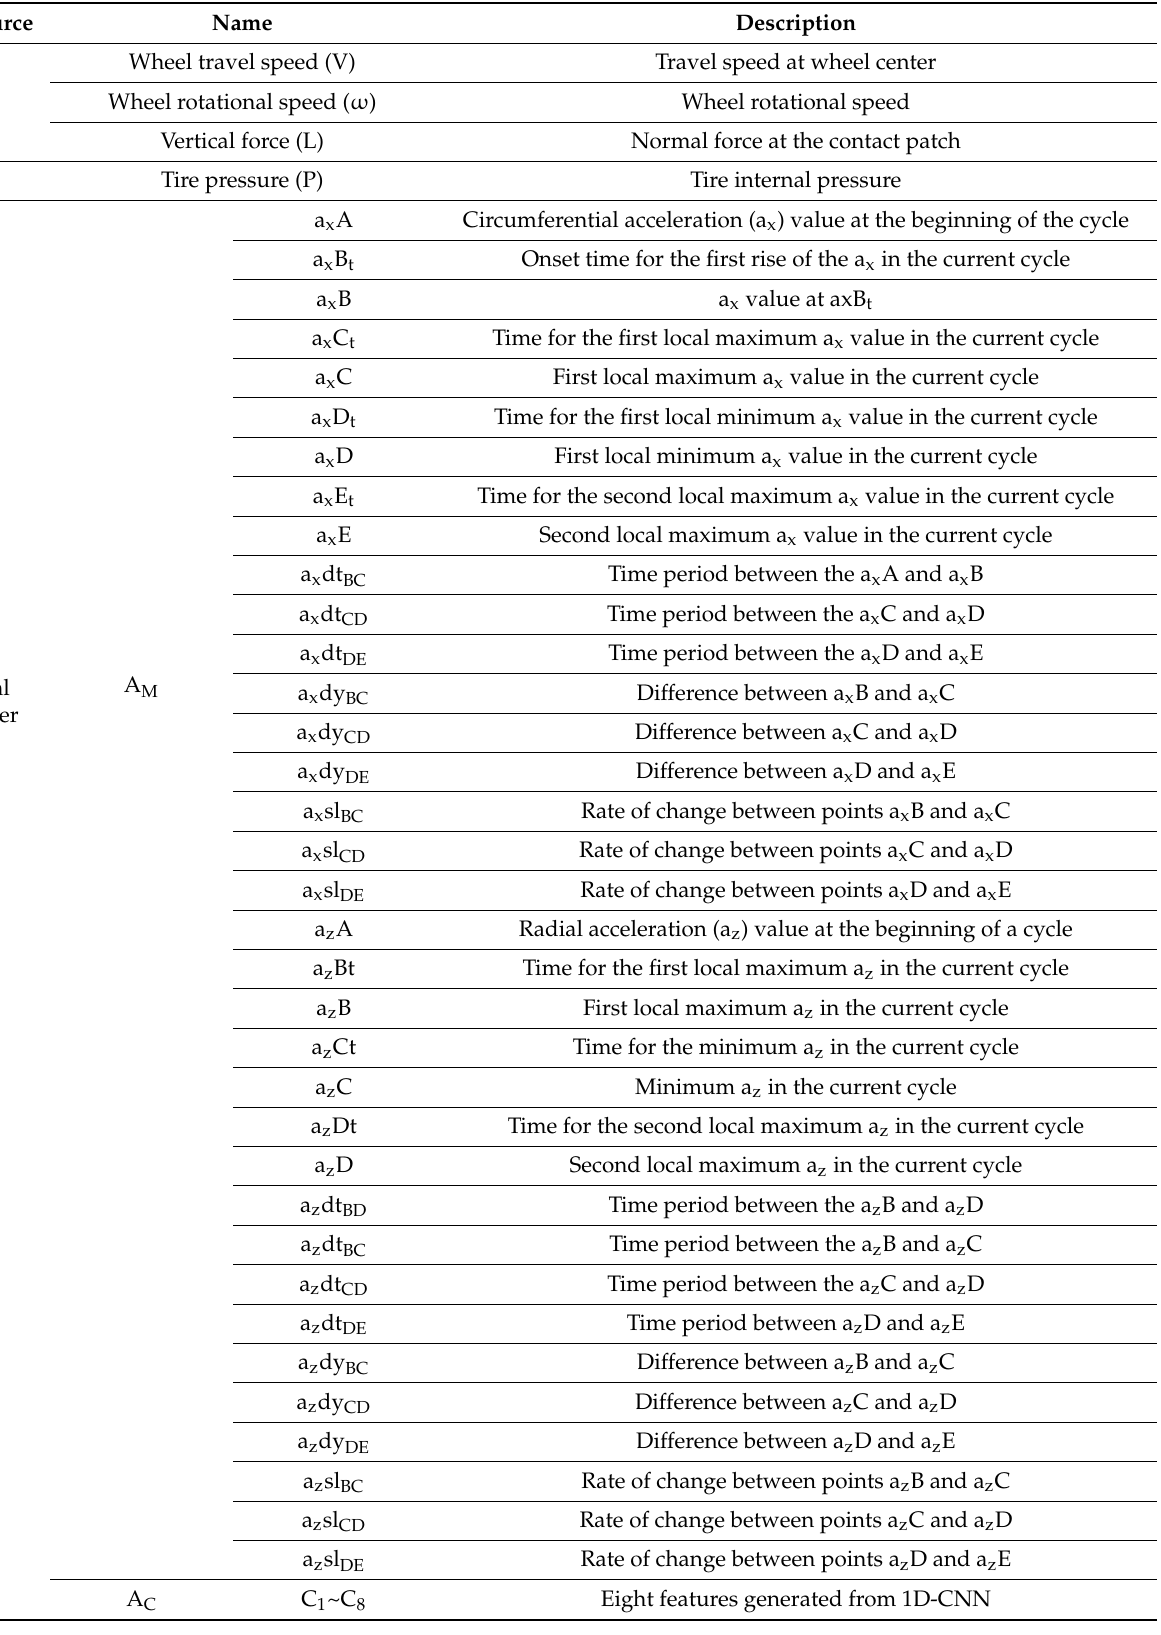
Table 2. List of features for machine learning-based wear prediction